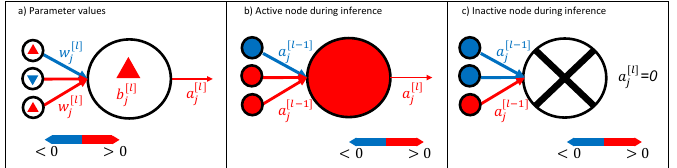
Figure 2. Visualization method for neural networks. It is possible to visualize the trained neural network weights W and biases b , as shown in ( a ). During inference, active neurons (activation A ) transport a signal, as shown in ( b ), whereas it is also possible to have inactive neurons that do not transport any signal; see ( c ). Note that we use lowercase letters to indicate the components of the vectors and